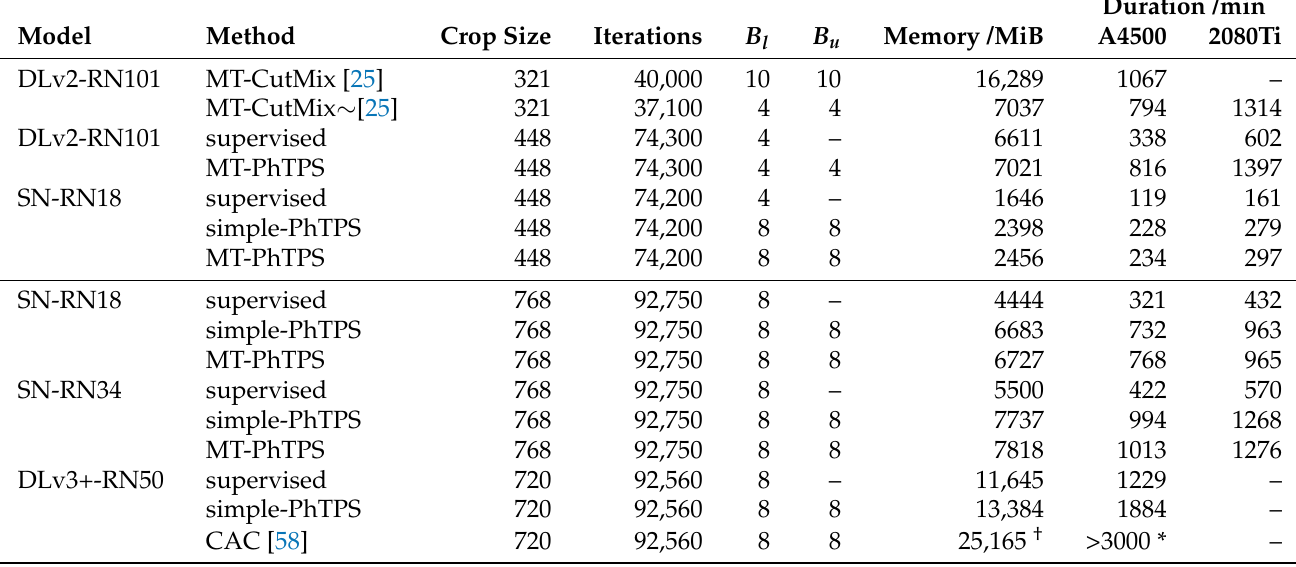
Table A3. Half resolution Cityscapes (top section) and Cityscapes (bottom section) maximum memory allocation and training time on two GPUs.